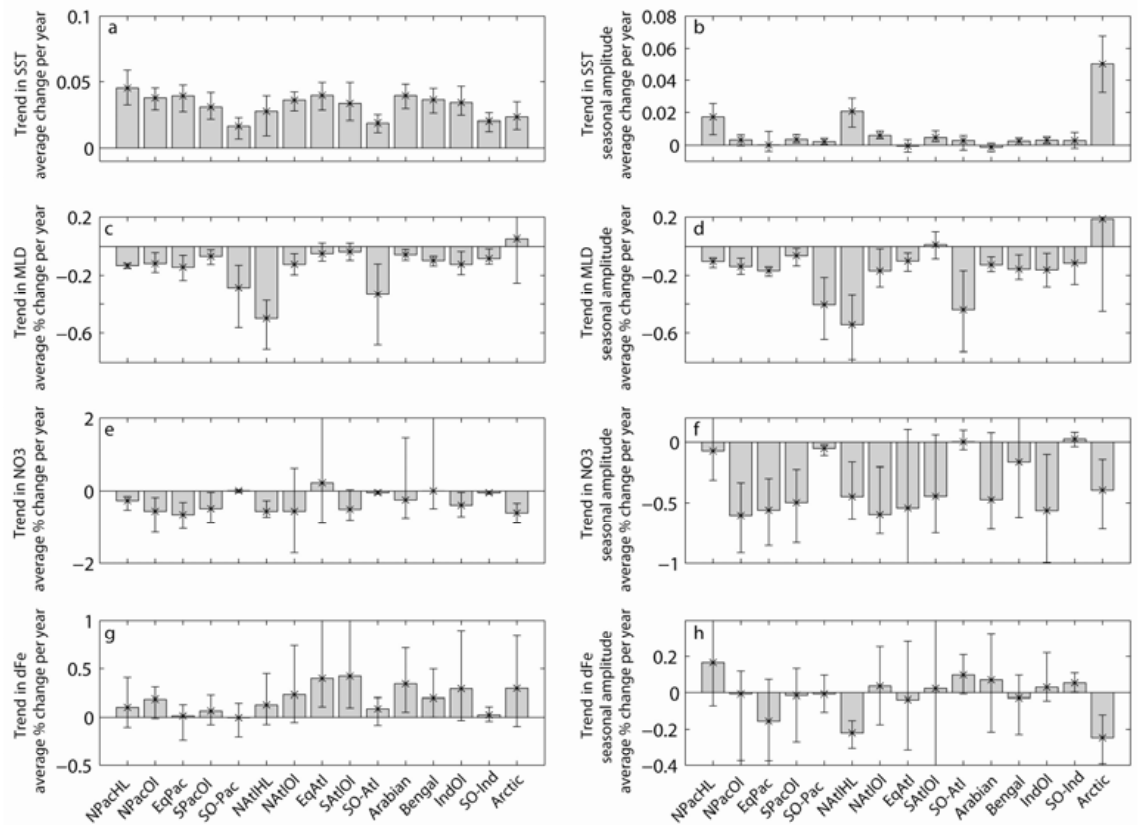
Fig. 6. Biome mean trends and standard deviations for 6 coupled models forced with IPCC AR5 scenario RCP8.5 until 2100 expressed as average % change per year, except SST which is shown in average ◦ C change per year. (a) Mean annual SST, (b) seasonal amplitude Figure 6: Biome mean trend and standard deviation for 6 coupled models forced with of SST, (c) mean annual MLD, (d) seasonal amplitude of MLD, (e) mean annual surface nitrate concentration, (f) seasonal amplitude of surface nitrate concentration, (g) mean annual surface dissolved iron concentration and (h) seasonal amplitude of surface dissolved iron IPCC AR5 scenario RCP8.5 to 2100 expressed as average % change per year, except concentration. Biome labels are the same as in Fig. SST which is shown in average °C change per year. a) Mean annual SST, b) seasonal amplitude of SST, c) mean annual MLD, d) seasonal amplitude of MLD, e) mean annual surface nitrate concentration, f) seasonal amplitude of surface nitrate concentration, g) mean annual surface dissolved iron concentration and h) seasonal amplitude of surface dissolved iron concentration. Biome labels are the same as in